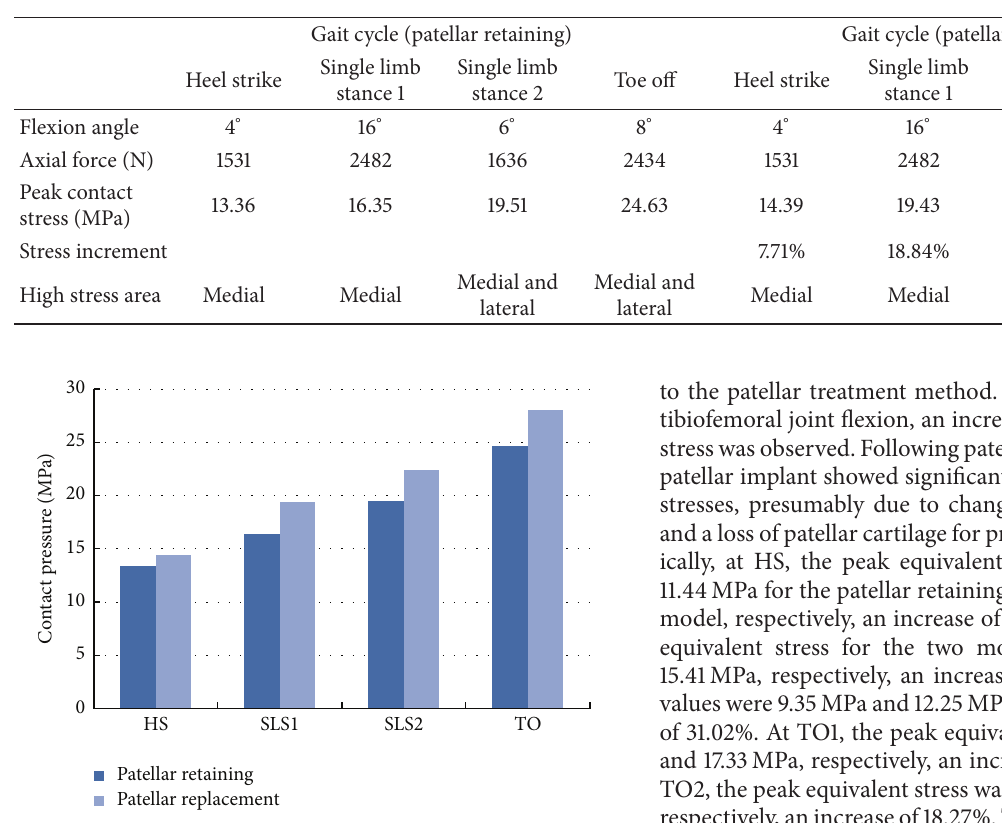
Table 2: Knee tibial tray mechanical properties during the gait cycle.